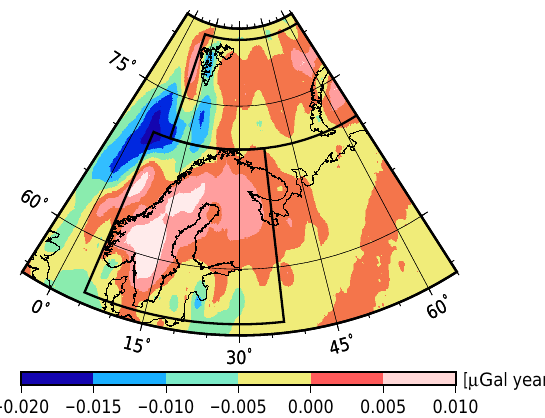
Figure 6. Gravity rate due to GISR according to the Amantov model for viscosity profile M4-16-80. Boxes around Scandinavia and in the Barents Sea denote the areas for which the maximum gravity rate is given in Table